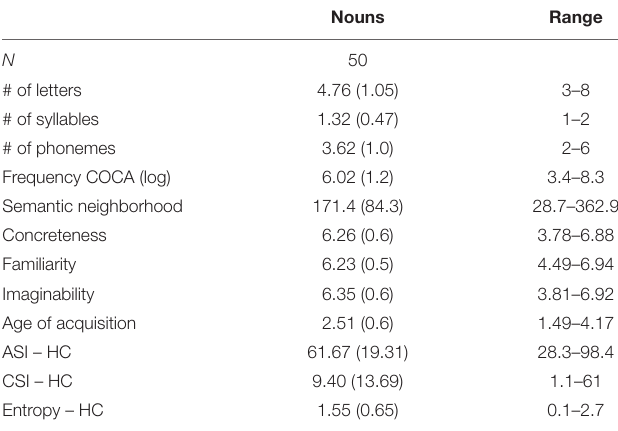
TABLE 2 | Psycholinguistic characteristics of the